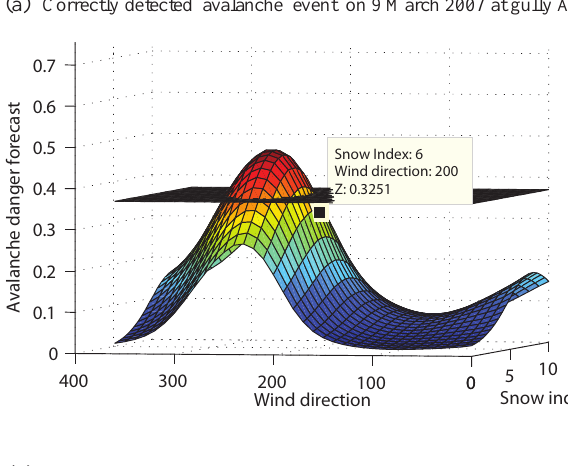
3 rd of March (b) Missed avalanche event on the 2007 at gully B.